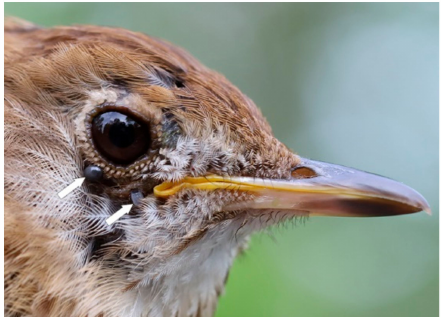
Figure 4. Veery, after-second year male, infested with three I. scapularis nymphs. One fully engorged nymph moulted to a male in 31 d. On 22 July 2019, this bird was moulting to prepare for the southward flight to its wintering range in Brazil. Photo credits: Simon